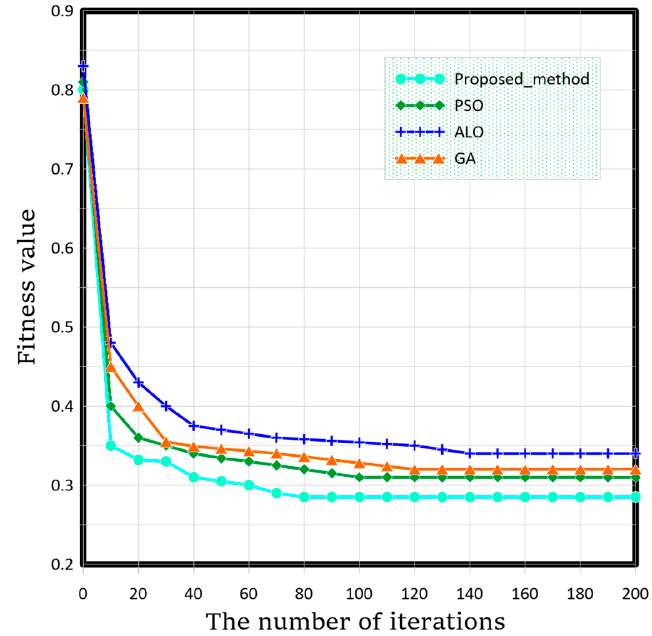
Figure 4. The result of convergence in 200 iterations.